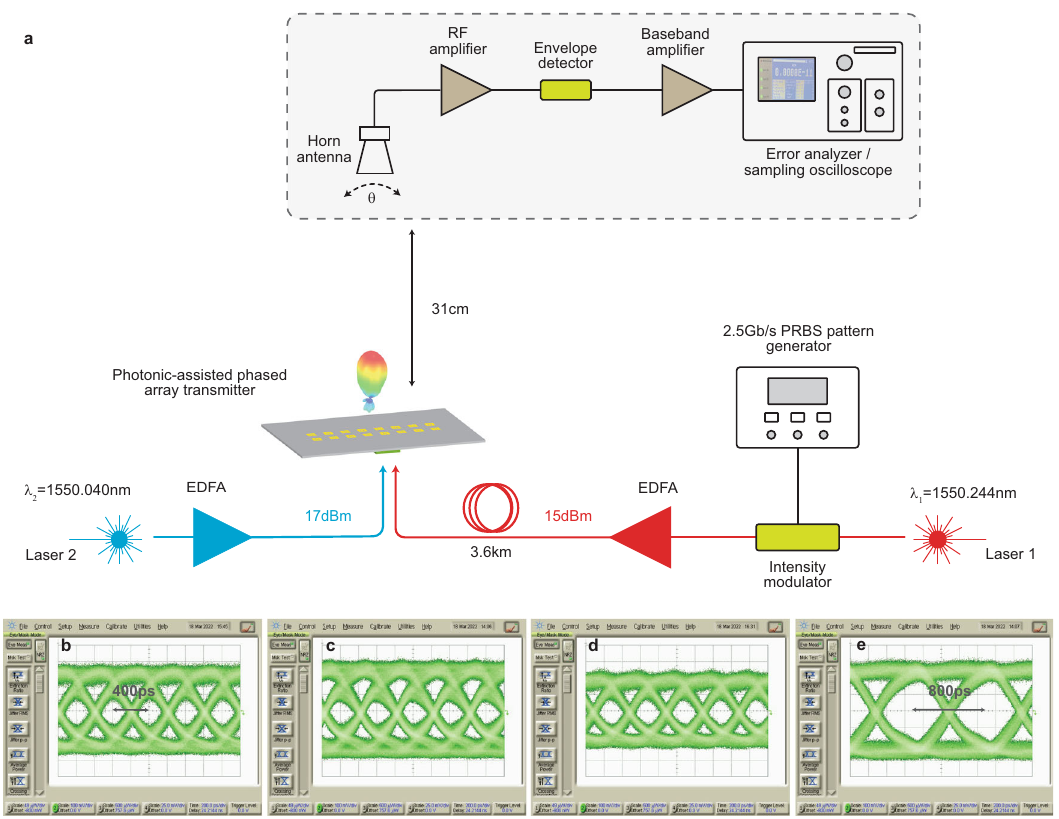
Fig.7|Opticalandwirelessdatatransmission.a Measurementsetupofanoptical fi ber to mm-wave wireless link. The eye diagrams of the detected data streams (at 2.5Gb/s)aftertravelingover3.6kmofoptical fi berandwirelesstransmissionatthe